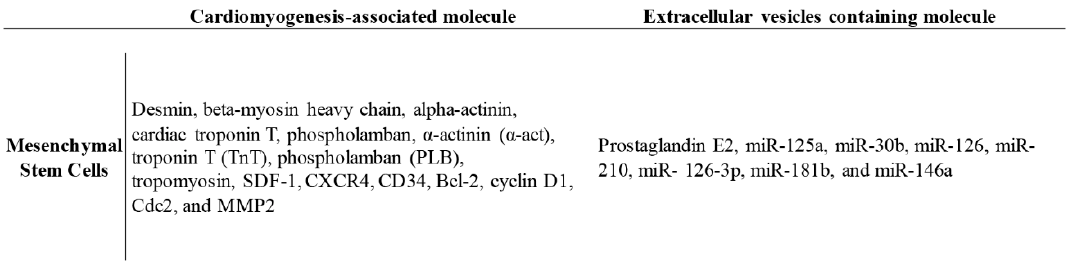
Figure 2. The potential molecules involved in the progression of cardiomyogenesis and/or contained in the extracellular vesicles that regulate MSC functions.